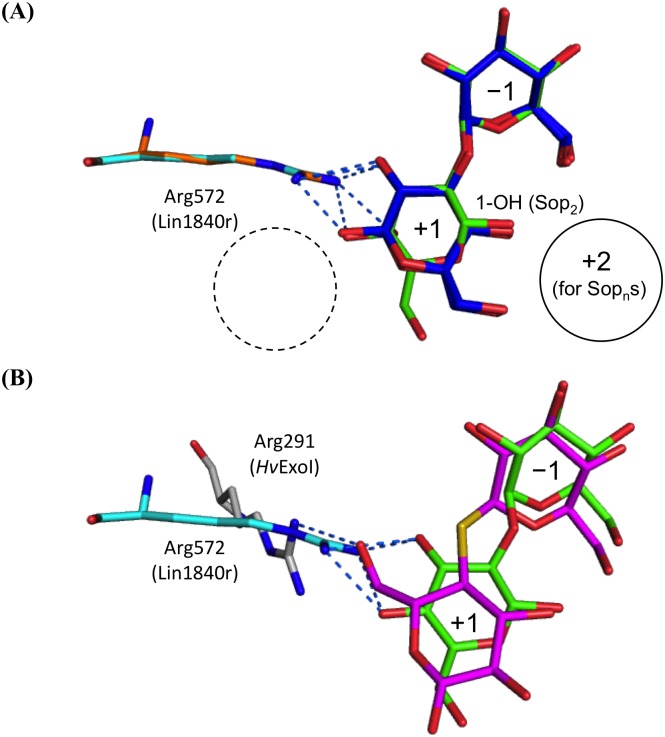
Comparison of conformations of ligands in Lin1840r and HvExoI.Hydrogen bonds are represented as blue dotted lines. Subsites −1, +1, and +2 are labeled. (A) Comparison of Sop2 and Lam2 in the D270A mutant. Arg572 and Sop2 in the D270A-Sop2 complex are shown in cyan and green, respectively. Arg572 and Lam2 of both anomers in the D270A-Lam2 complex are colored orange and blue, respectively. Putative subsite +2 for Sopns and potential subsite +2 for Lamns are shown in a solid and dotted circle, respectively. An anomeric hydroxy group of a reducing-end glucoside in Sop2 is labeled. (B) Comparison of Sop2 in the D270A mutant and thioCel2 in HvExoI. The residue and ligand in the D270A-Sop2 complex are shown in the same as in (A). Arg291 and thioCel2 in HvExoI-thioCel2 are presented in gray and magenta, respectively.